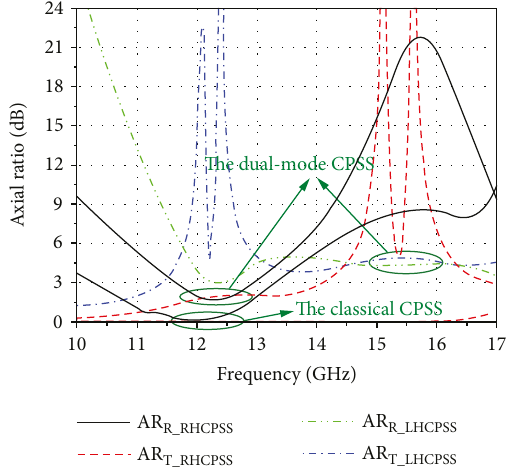
Figure 5: Comparison of the ARs between the dual-mode CPSS and the classical CPSS in re fl ection and transmission